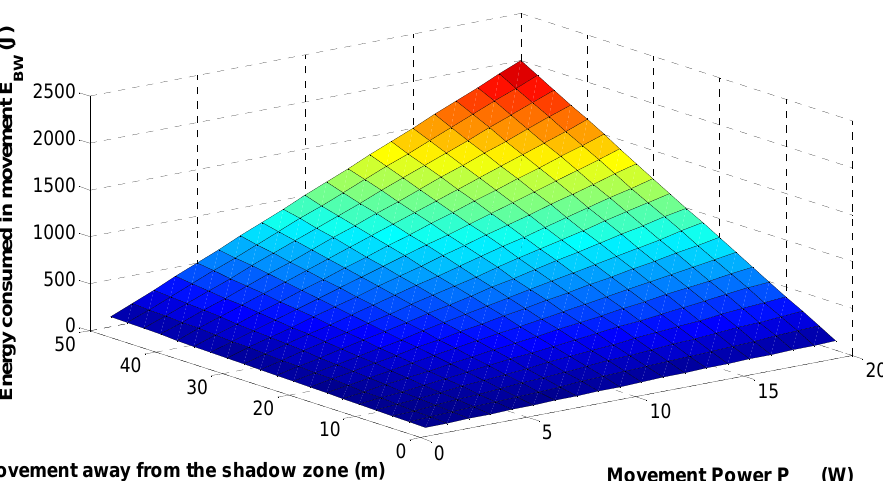
Figure 15. Energy consumption in the sensor